Question: What form of chart is displayed?
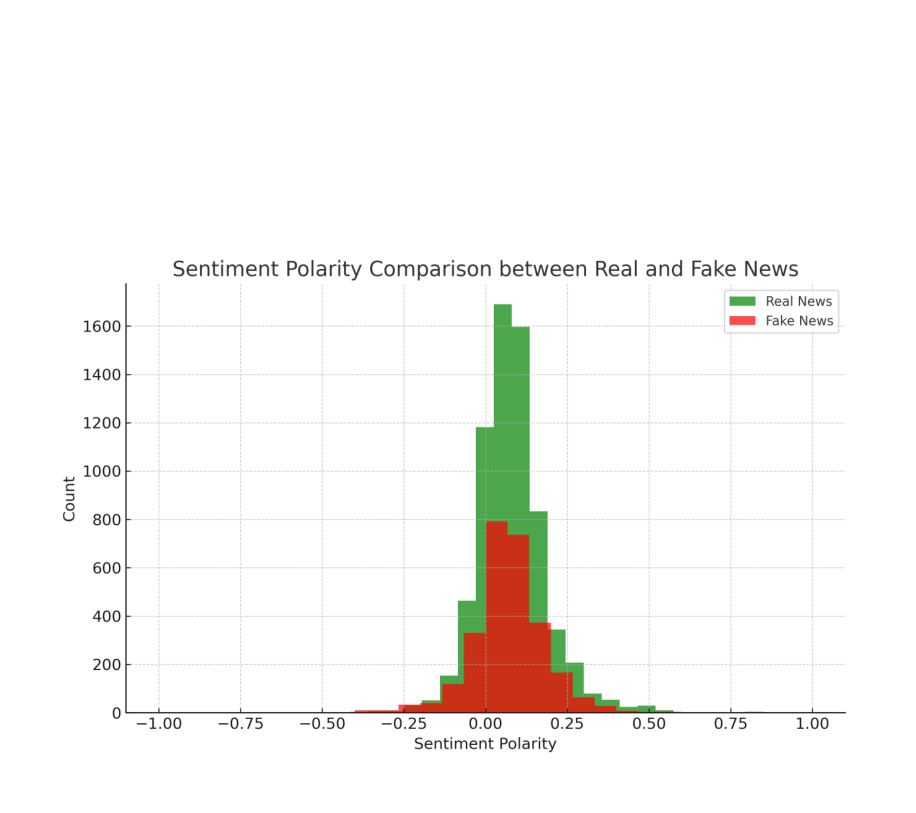
Answer: histogram